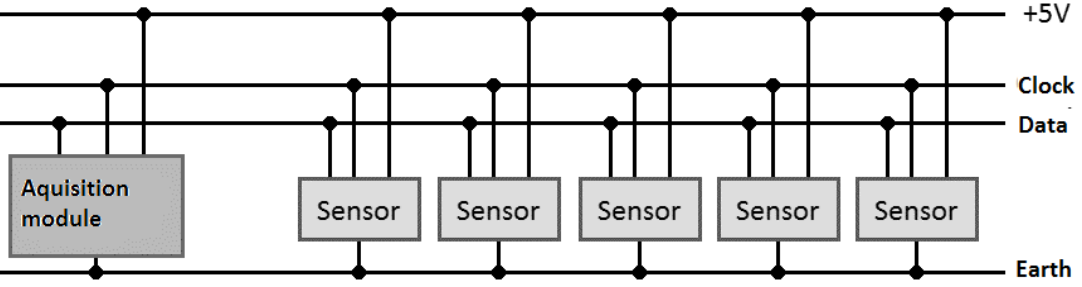
Figure 29. Communication of a master I2C with several slave sensors in the same bus.